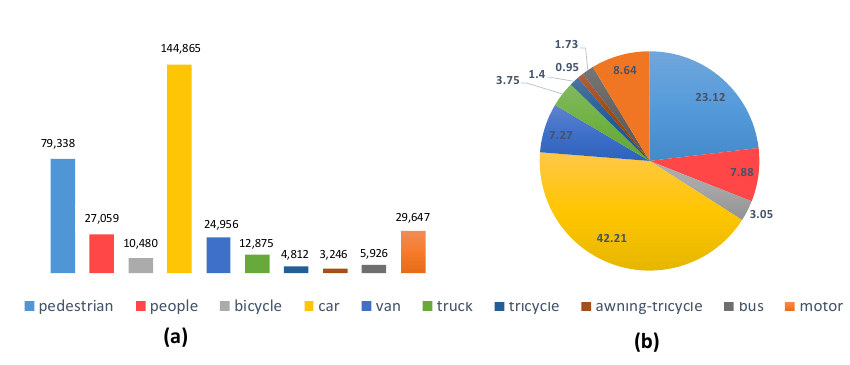
Figure 7. The visdrone2018 dataset of ( a ) the number of objects and ( b ) the proportion of various